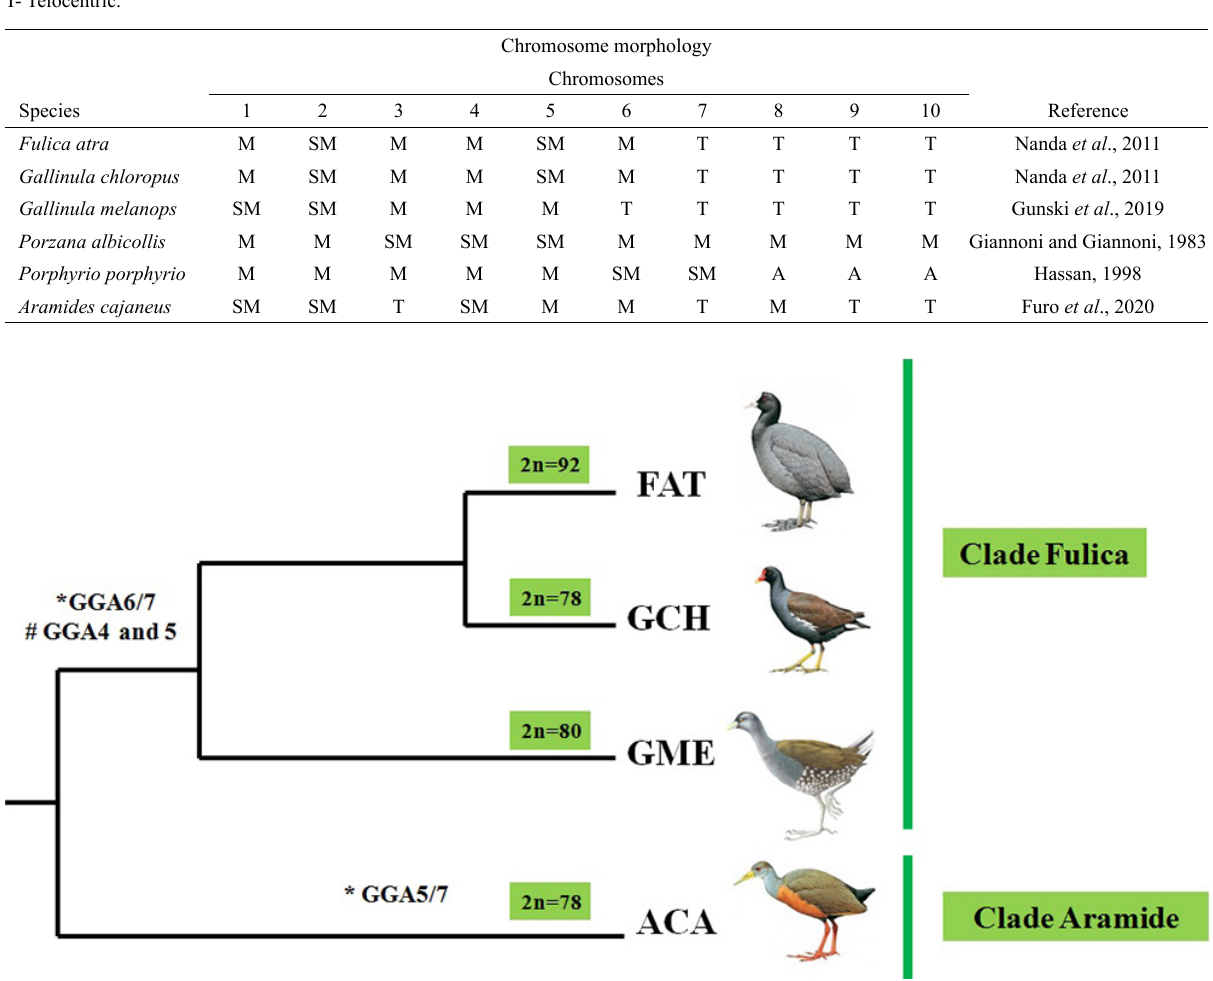
Figure 5 – An adaptation of the phylogenetic tree proposed by Garcia-R et al . (2014), plotted with FISH data from G.gallus probes (Legend: FAT- Fulica atra ; GCH- Gallinula chloropus ; ACA- Aramides cajaneus ; GME- Gallinula melanops ). (*) correspond fusion and (#) fission.